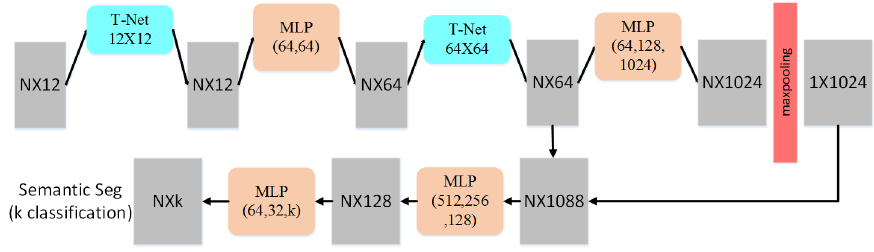
Figure 5. The network structure of our method